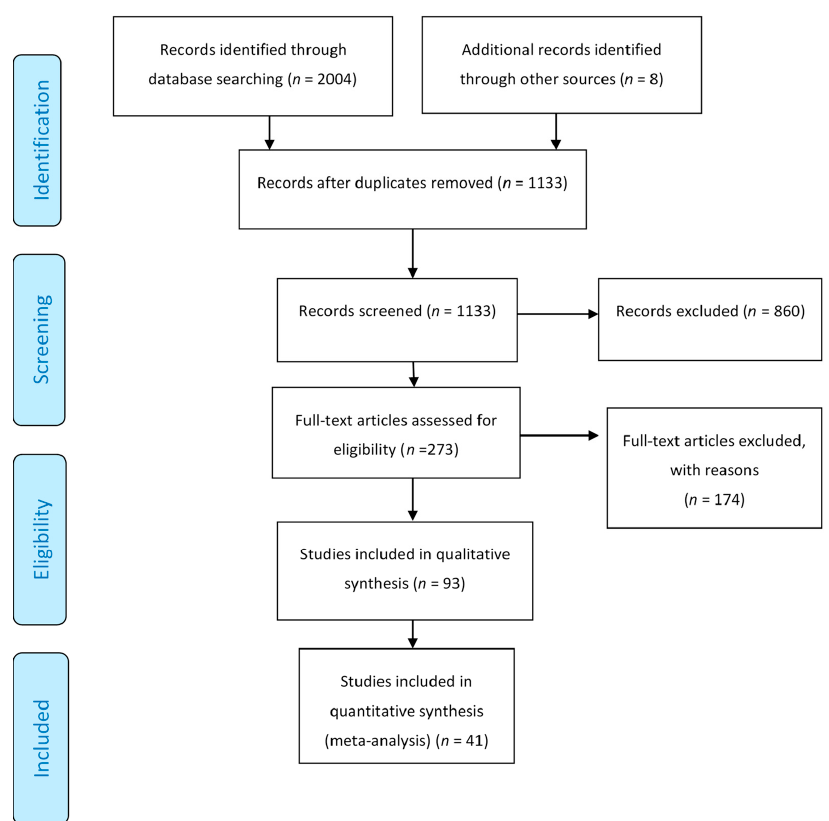
Figure 1. Flow diagram of the process of study selection.